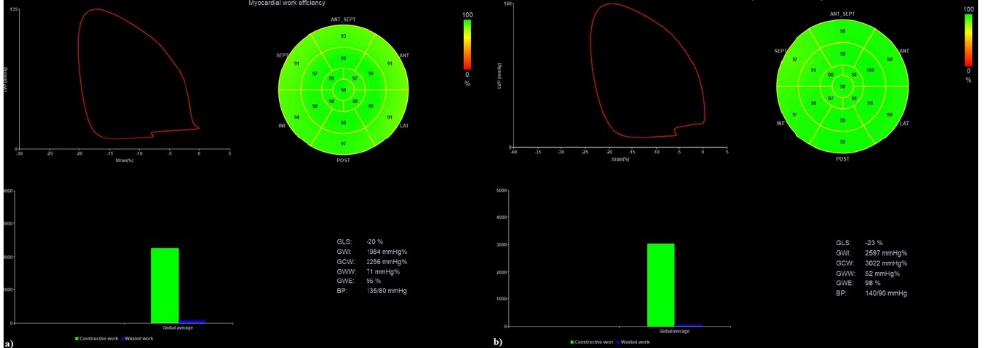
Figure 2. Myocardial work analysis in recovered COVID-19 patients.